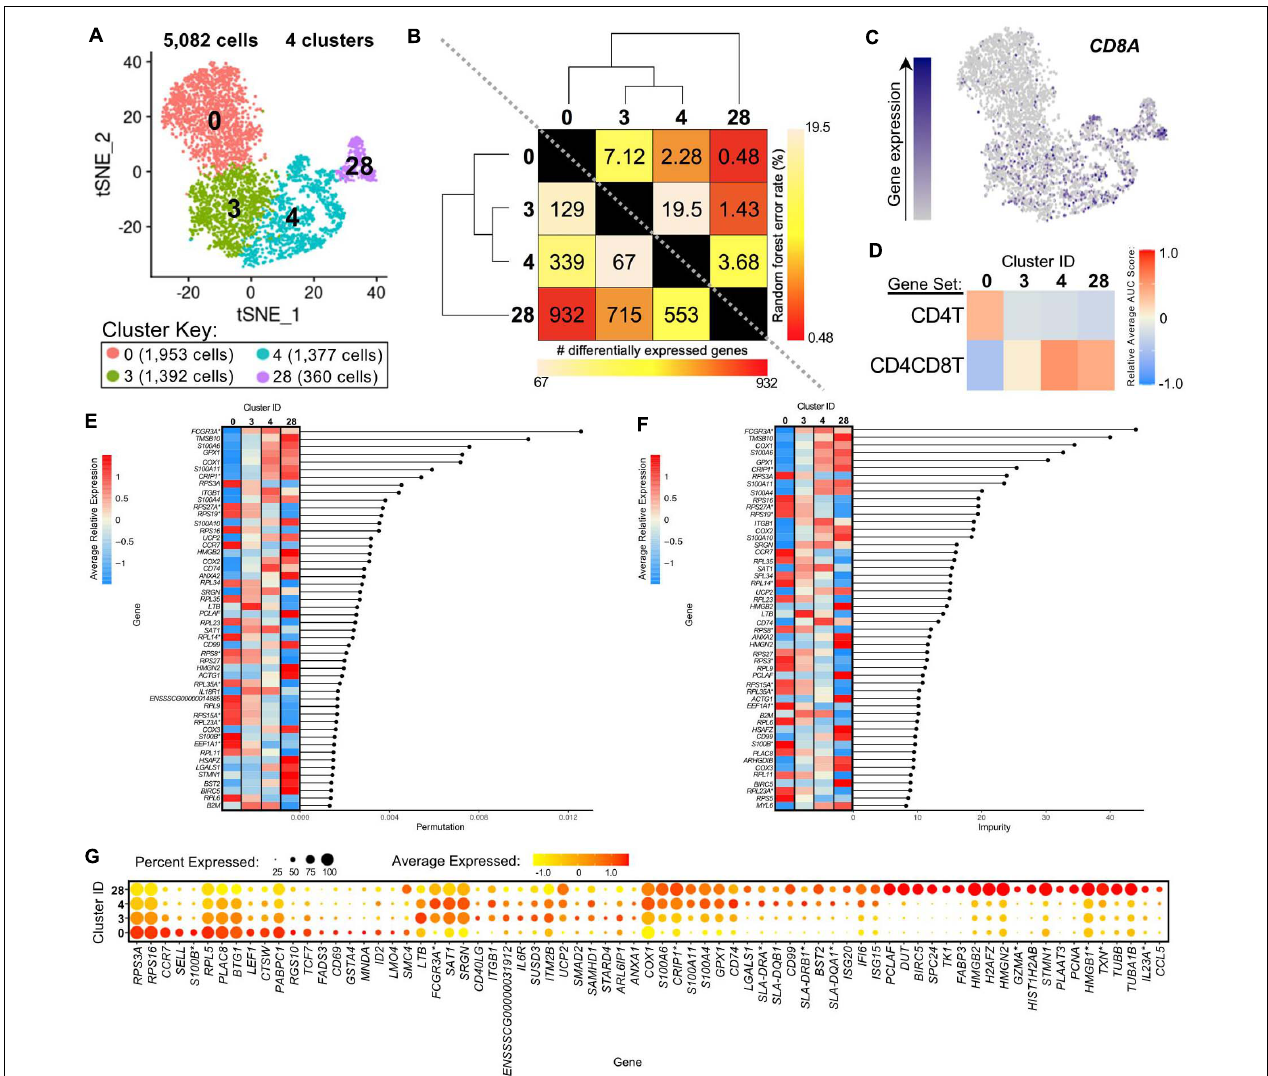
FIGURE 7 | Transcriptional heterogeneity of porcine CD4 + αβ T-cells at single-cell resolution. (A) Two-dimensional t-SNE plot of 5,082 cells belonging to clusters designated as CD4 + αβ T-cells (clusters 0, 3, 4, and 28) in Figure 4D . Each point represents a single cell. Color of the cell corresponds to transcriptional cluster a cell belongs to. Cells more transcriptionally similar to each other belong to the same cluster. (B) Transcriptomic relationship amongst CD4 + αβ T-cell clusters as calculated by three methods: hierarchical clustering (as seen by hierarchical trees on both axes), pairwise random forest analyses (as seen on top right diagonal); and pairwise DGE analyses (as seen on bottom left diagonal). Longer branches on the hierarchical tree corresponds to greater hierarchical distance. Lower numbers of DEGs by DGE analysis and higher out-of-bag (OOB) error rates from random forest analyses indicate greater pairwise transcriptional similarity. (C) Visualization of CD8A expression overlaid onto t-SNE coordinates of single CD4 + αβ T-cells. Each point represents a single cell. Color of the point corresponds to relative expression of CD8A within a cell. Gray corresponds to little/no gene expression, while navy corresponds to increased gene expression. (D) Relative average gene set enrichment scores of CD4 + αβ T-cell clusters calculated by AUCell analysis of DEG sets from pairwise DGE analysis of the CD4T and CD4CD8T populations from porcine bulkRNA-seq. Scores are relative to other cells within a single gene set comparison (across a row of the heatmap) and are not calculated relative to scores across gene set (across columns in the heatmap). (E,F) Genes with the largest effects in discriminating CD4 + αβ T-cells by cluster identities were determined, as indicated by high permutation (E) and/or impurity scores (F) calculated from a trained random forest model. Average relative expression for each of these genes within clusters is also depicted by a heatmap. (G) Dot plot of up to the top 20 DEGs having logFC > 0 from overall DGE analysis of only CD4 + ab T-cell clusters. Clusters are listed on the y -axis, while selected DEGs are listed on the x -axis. The size of a dot corresponds to the percent of cells in a cluster that expressed the gene. The color of a dot corresponds to the average relative expression level for the gene in the cells expressing the gene within a cluster. *Refer to ‘Gene name replacement’ methods.